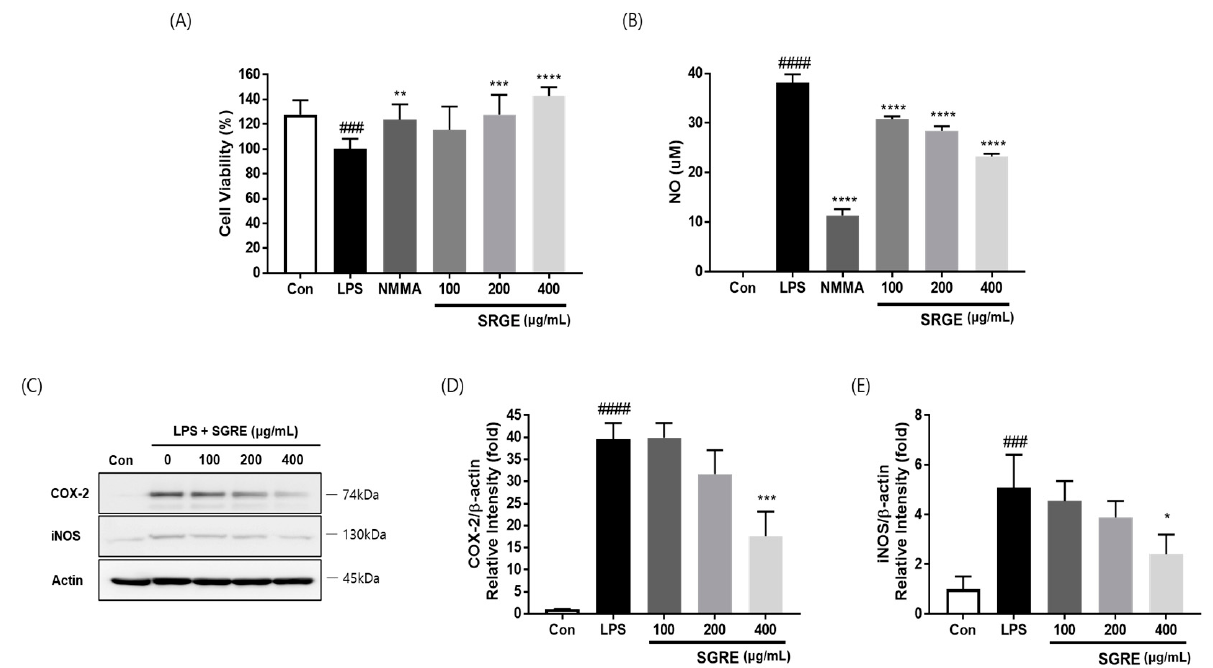
Figure 2. E ff ect of SGRE on NO production and COX-2 and iNOS expression in LPS-stimulated RAW264.7 macrophages. ( A ) Cell viability was measured using the MTT assay. ( B ) The culture su- pernatants were subsequently isolated and their NO levels were analysed. ( C ) The cells were lysed, and the lysates were analysed via immunoblo tt ing using anti-COX-2 and anti-iNOS antibodies. ( D , E ) The intensity of the bands was quanti fi ed using Image J software. ### p < 0.001; #### p < 0.0001 vs. control cells. * p < 0.05; ** p < 0.01; *** p < 0.001; **** p < 0.0001 vs. LPS-treated cells.